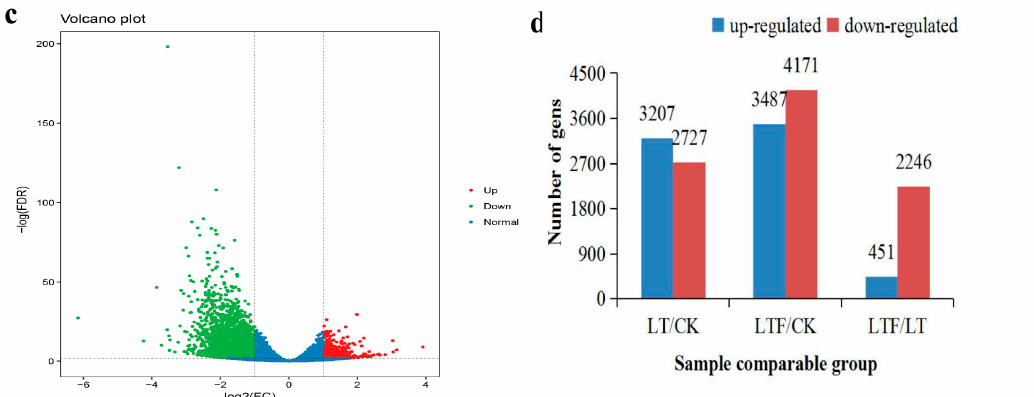
Figure 3. Volcano plot of differentially expressed gens. ( a ) LT/CK ( b ) LTF/CK ( c ) LTF/LT. LT, low temperature treatment for 3 d; LTF, low temperature flooding treatment for 3 d; CK, control. The green dots mean the down-regulated genes, the red dots mean the up-regulated genes, and the blue dots mean the non-significant differentially expressed genes. ( d ) Number of leaves genes up-and down-regulated. The blue column and red column represent the number of up-regulated and down-regulated genes, respectively.